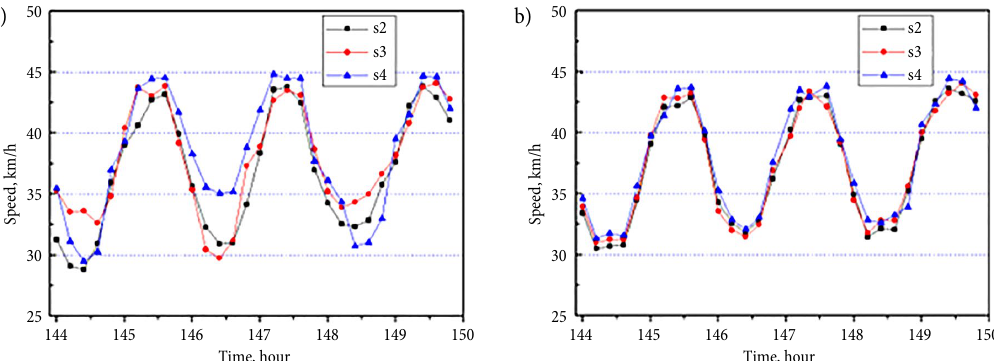
Fig. 9. Average speed of s 2, s 3 and s 4 in the last 6 h when the VMS is set at Node 2 (a) and 140 m from the front of Node 2 (b)